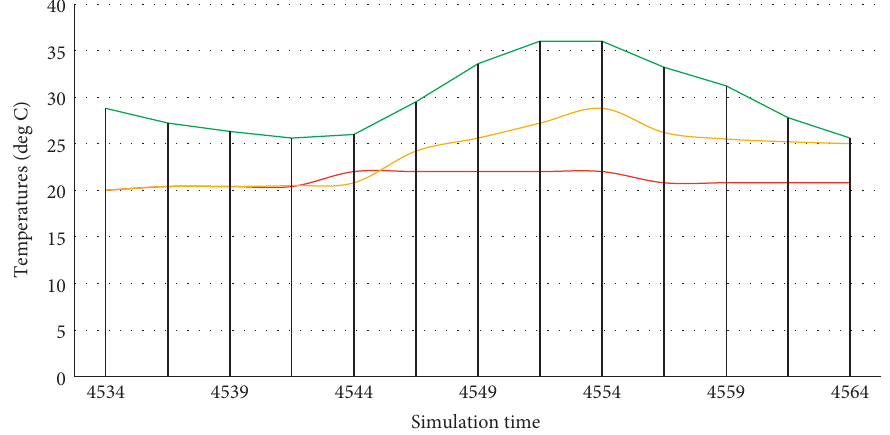
Figure 7: Temperature output at 22 ° C.